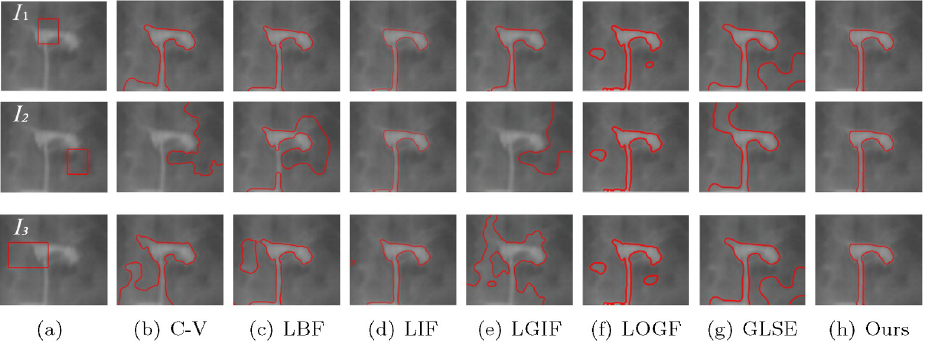
Fig 6. Comparisons for a tubal angiography image with varying initial